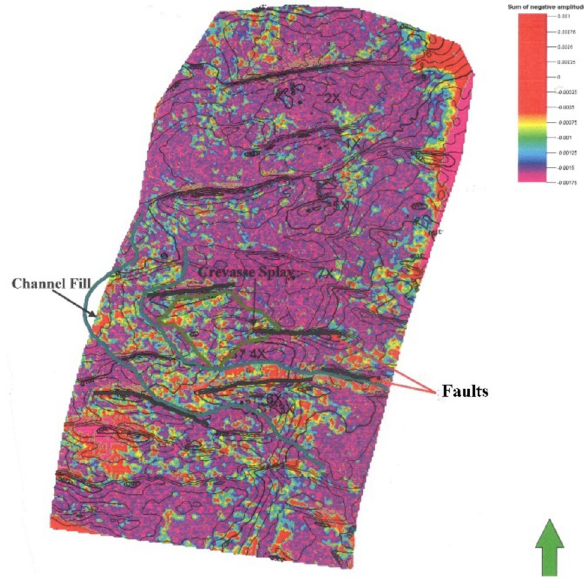
Fig. 6 Example of flow expansion in the river–lake transition area, observed at Lago Poopó Lake,